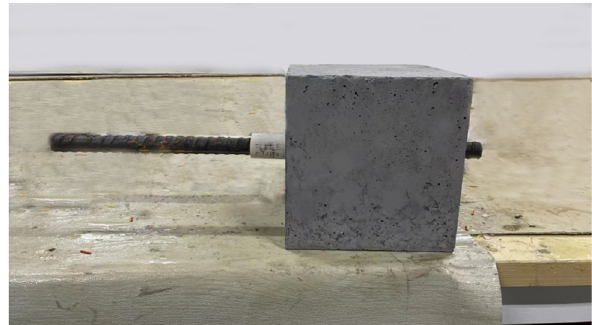
Figure 4: Pull - out the test specimen.